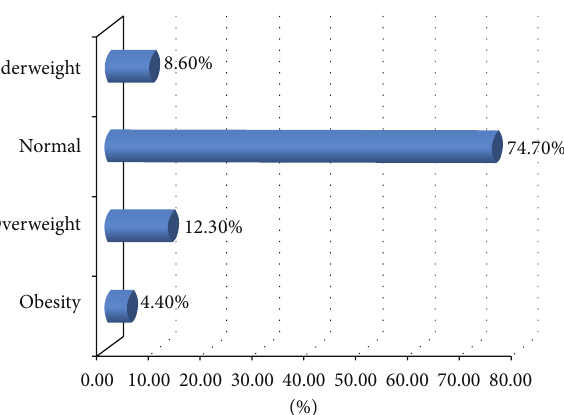
Figure 1: BMI of high school students in Bahir Dar city, North West Ethiopia,